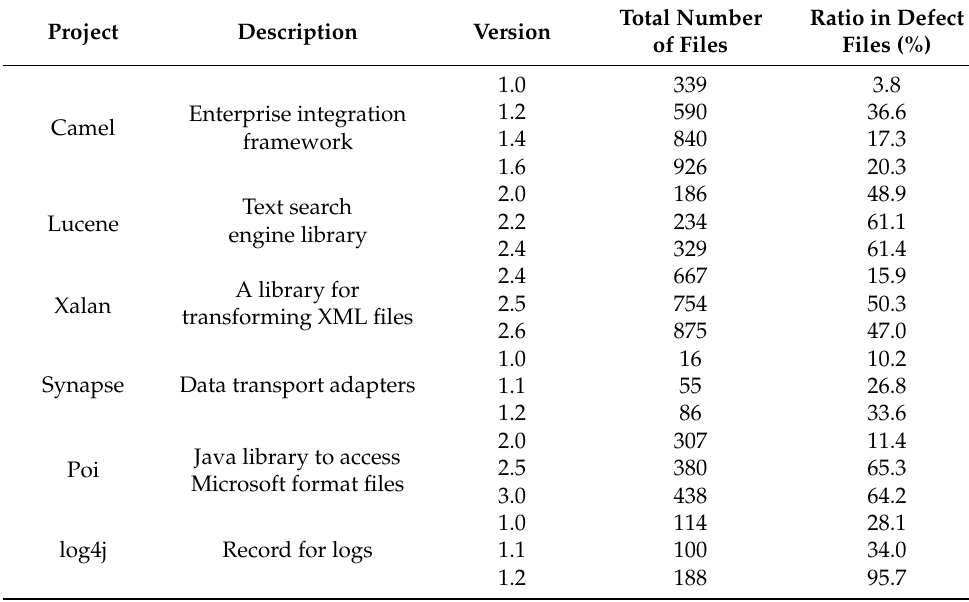
Table 1. The details in the Promise project